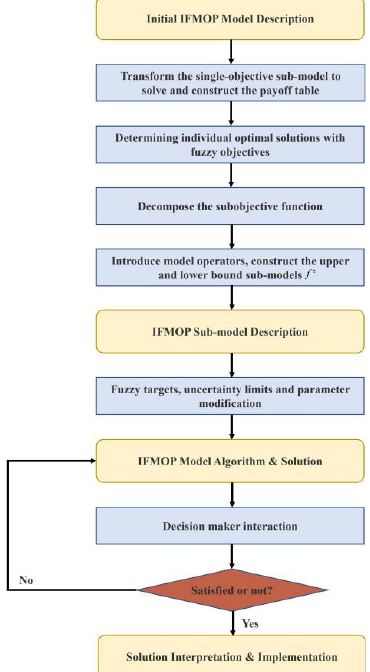
Figure 3. Flowchart of the IFMOP model solution steps.